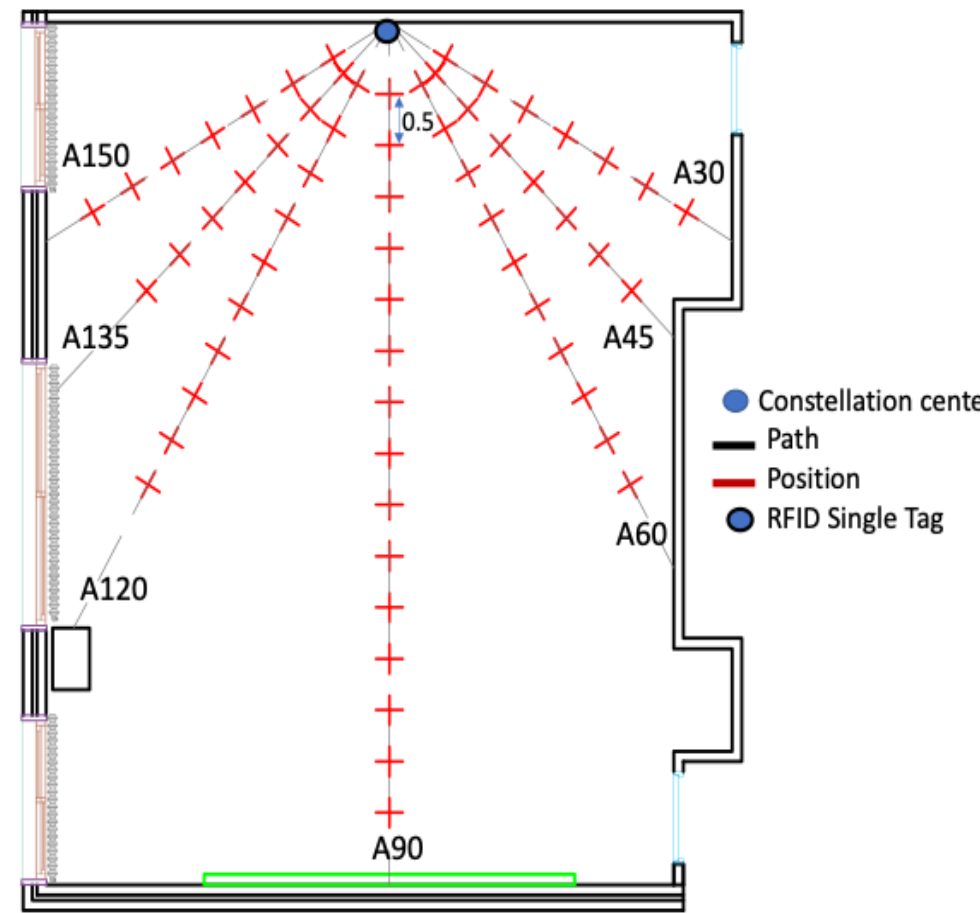
Figure 5. Two-dimensional layout of the classroom environment.